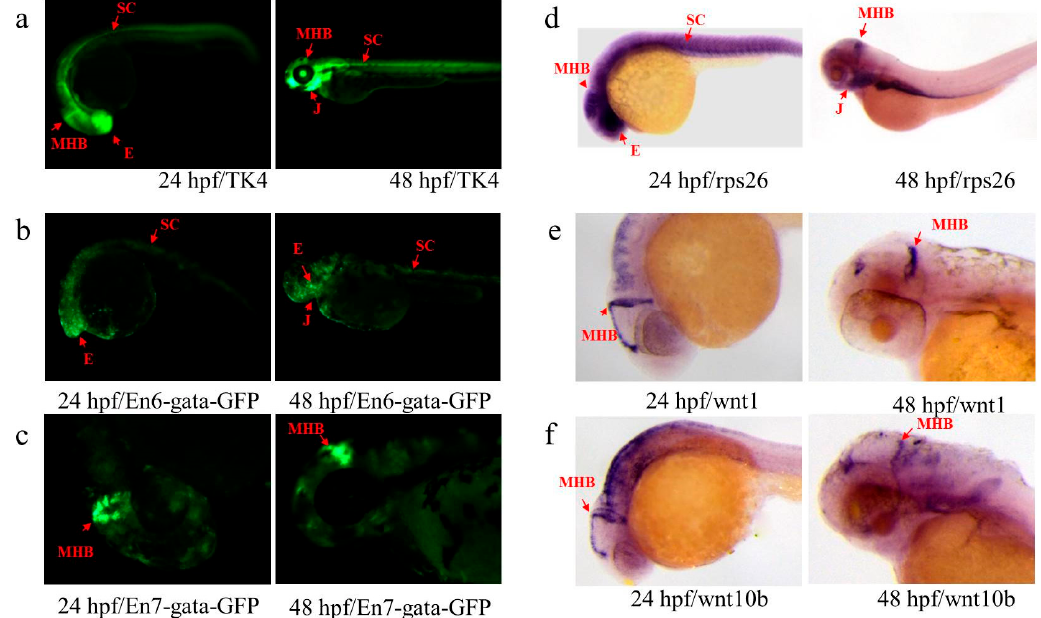
Figure 5. Expression patterns of En and endogenous rps26 , wnt1 and wnt10b in TK4. ( a ) GFP expression of line TK4 at 24 and 48 hpf; ( b , c ) GFP expression of the embryos injected with plasmids carrying En6 and En7 at 24 and 48 hpf, respectively; ( d – f ) gene expression of rps26 , wnt1 and wnt10b at 24 and 48 hpf, respectively. Red arrows indicate similar patterns in eye (E), midbrain and hindbrain boundary (MHB), spinal cord (SC) and jaw (J).